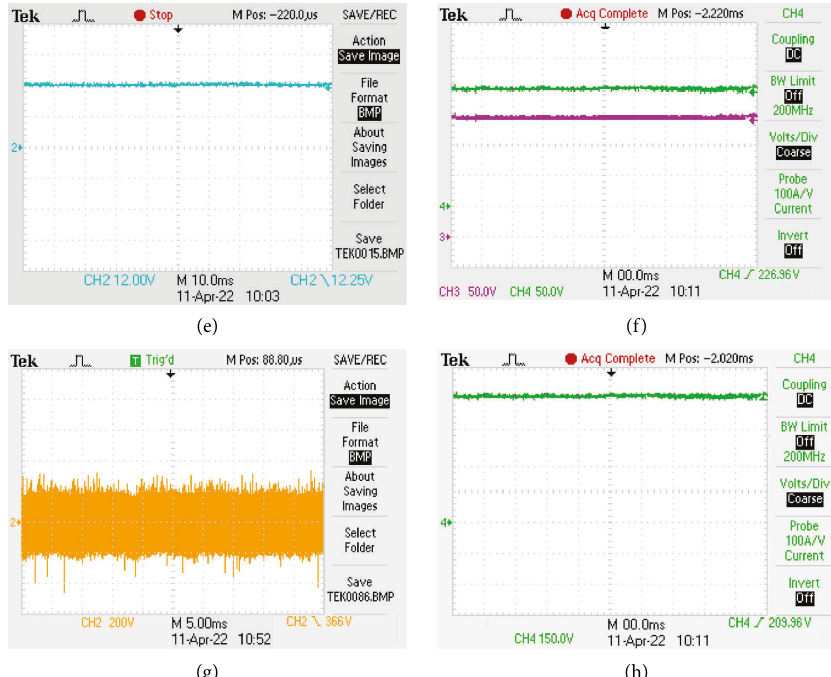
Figure 20: Experimental results of the proposed MMPIFC boost converter prototype model. (a) PV array 1 voltage. (b) voltage across capacitors C A1 and C A2 . (c) Primary 1 voltage. (d) Secondary voltage. (e) PV array 2 voltage. (f) Voltage across capacitors C B1 and C B2 . (g) Primary 2 voltage. (h) DC bus